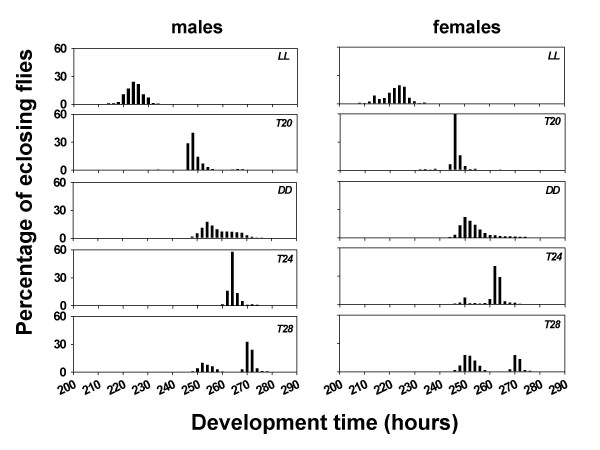
Eclosion profile of fruit flies D. melanogaster in five different light regimes. Pre-adult development time in hours is plotted along x-axis, and the percentage of eclosing flies is plotted along y-axis. Eclosion profile of males in five different light regimes is shown in the left panels, while that of females is illustrated in the right panels. Graphs were plotted using data pooled over four populations.